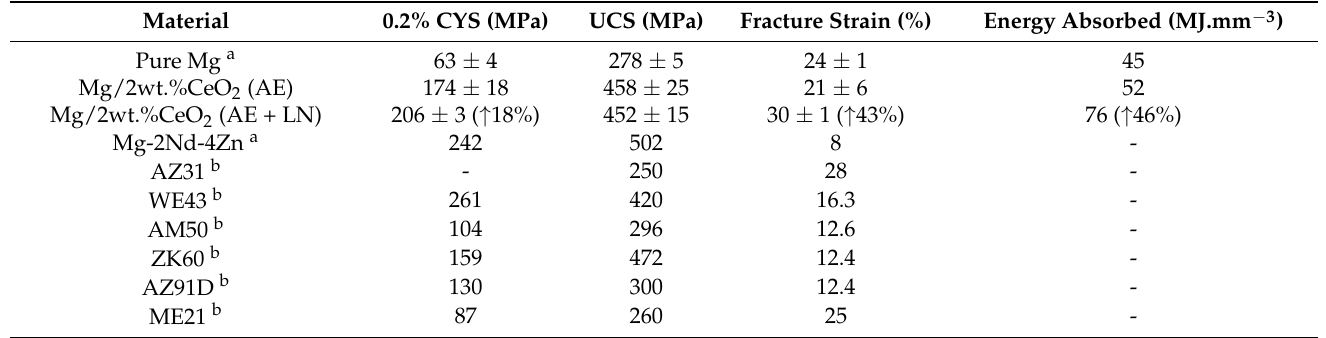
Figure 5. Schematic diagram showing the improvement in Mg/CeO 2 interfacial bonding and in- crease in quantum of compressive stresses from ( a ) as-cast; ( b ) extruded; ( c )DCT-treated samples.